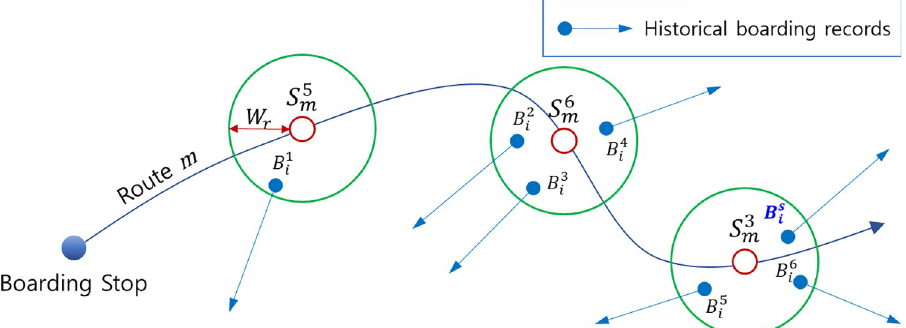
Fig 6. Concept of generating the historical trip (boarding) records. Note: S q s -th historical boarding stop of passenger i , and W r is the nearby radius (500 m in this study).